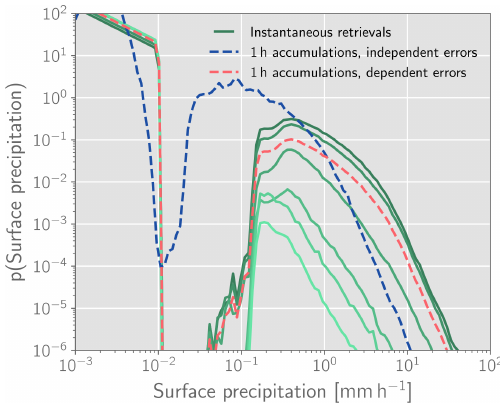
Figure 5. Retrieved posterior distributions of instantaneous precip- itation (green, solid lines) for an hour of ABI observations. The cor- responding derived distributions for the hourly accumulations are shown in red and blue for the assumptions of dependent and inde- pendent errors,